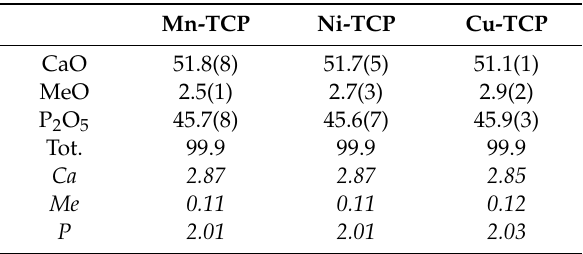
Table 2. Semi-quantitative EDS analyses for Ca 2.90 Me 0.10 (PO 4 ) 2 (Me = Mn, Ni, Cu) samples expressed in wt % (CaO, MeO, P 2 O 5 ) and atoms per formula unit (Ca, Me , P). Crystal formula is based on five